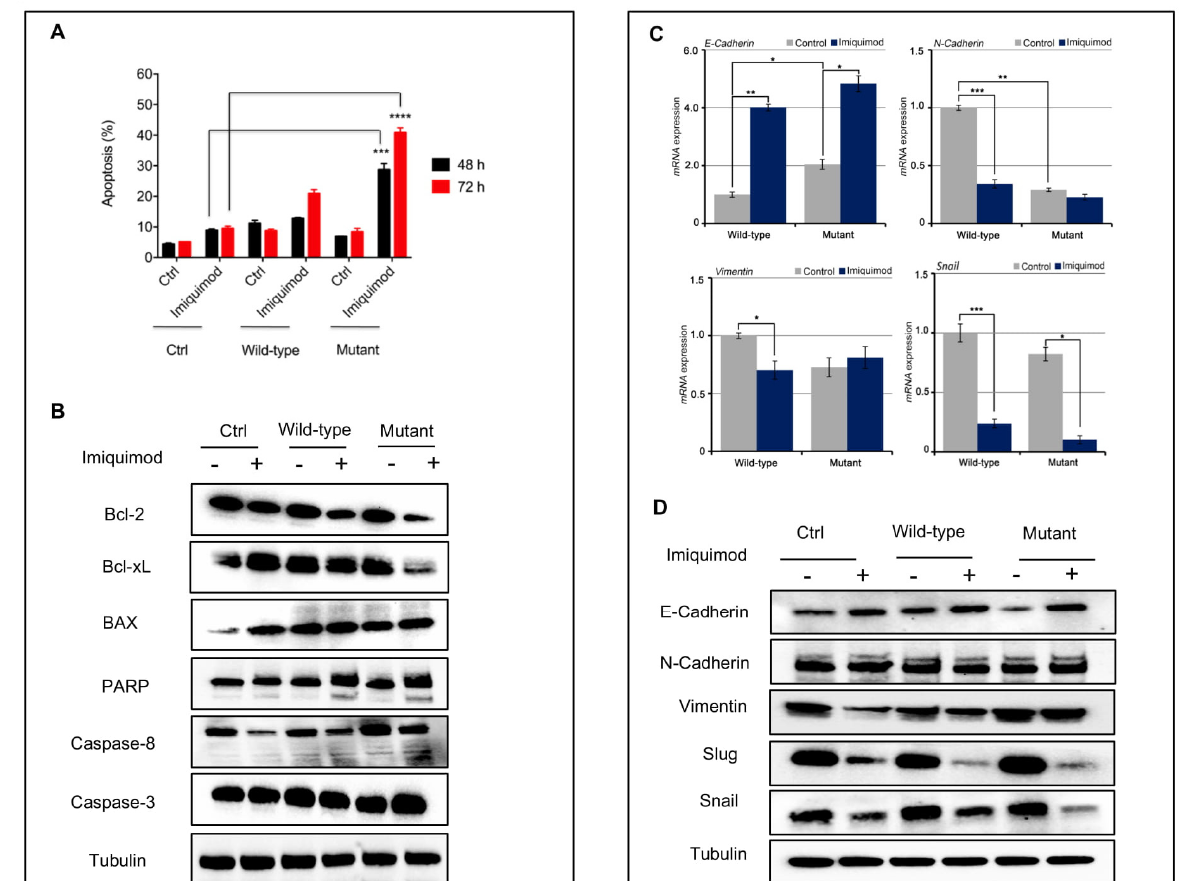
Figure 4. ( A ) Bar chart showing the percentage of apoptotic cells on MeWo cell lines following treatment with imiquimod (1 µ M) for 48 and 72 h; ( B ) Apoptotic markers after treatment with IMQ (1 µ M) in MeWo cells were evaluated by Western blot analysis (bar graphs in Supplementary Figure S2); ( C , D ) EMT markers before and after treatment with IMQ (1 µ M) in MeWo cells were evaluated by qRT-PCR and Western blot analysis (bar graphs in Supplementary Figure S3). Control: MeWo parental cell line; Wild-type: MeWo cell line transfected with SMO wild-type vector; MeWo cell lines: transfected with SMO mutant vector. * p < 0.1, ** p < 0.01, *** p < 0.001.